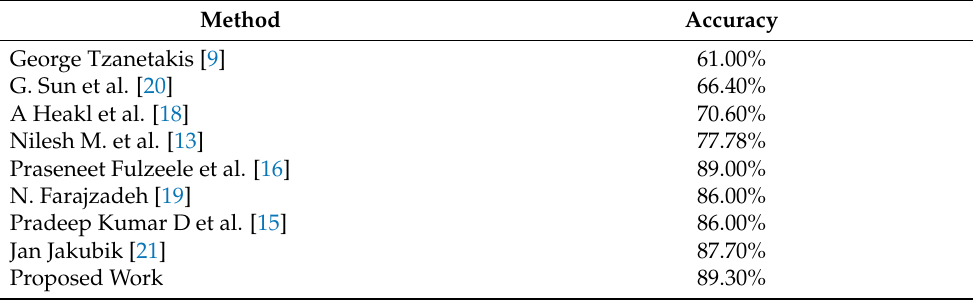
Table 3. Comparison between the proposed hybrid model and the other state-of-the-art